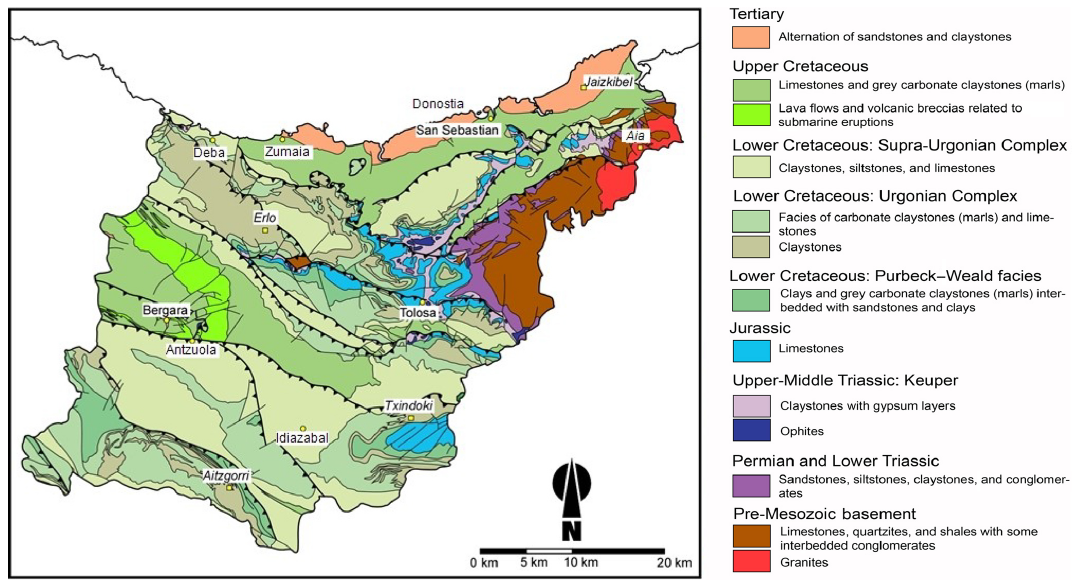
Figure 2. Geological sketch of Gipuzkoa province (modified from Ábalos,